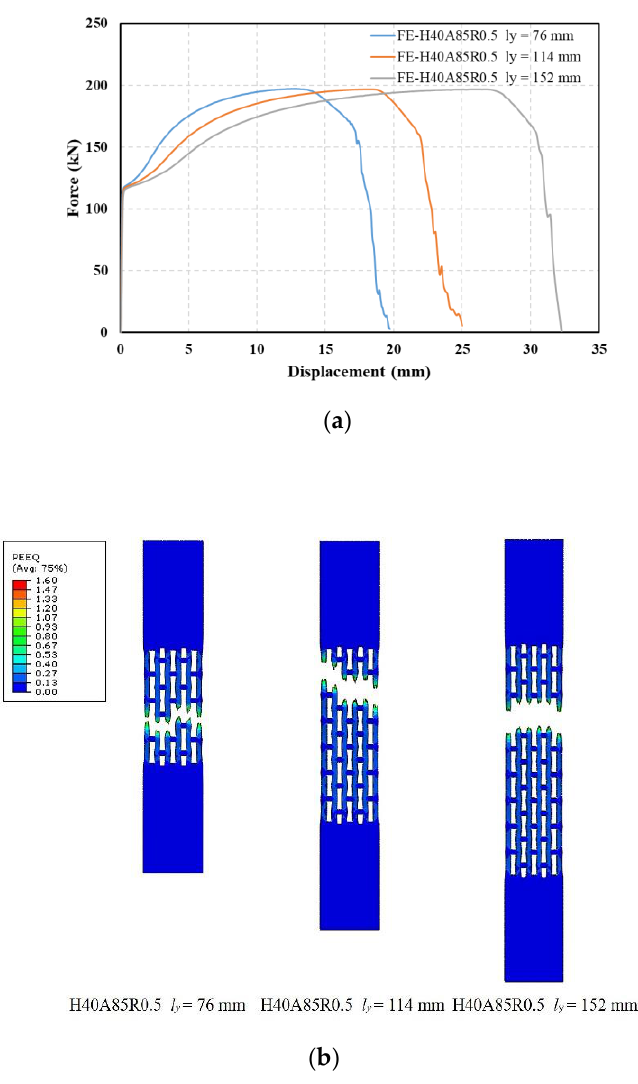
Figure 26. ( a ) Load–displacement curves and ( b ) failure modes of specimens with different perforated areas.